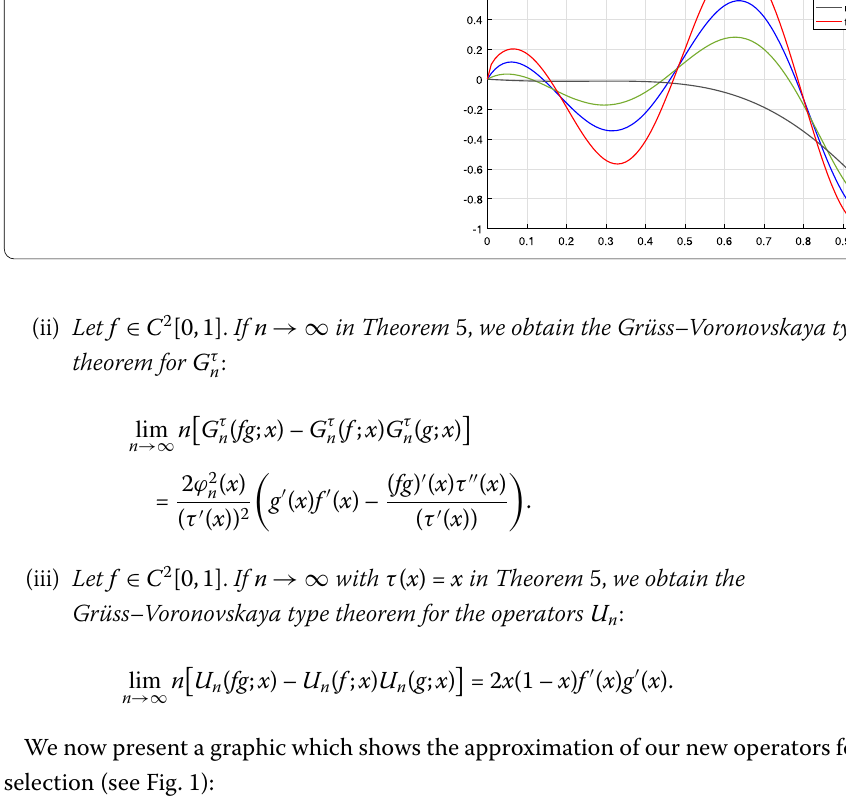
Figure 1 Approximation of f ( x ) by G τ n ( f ; x